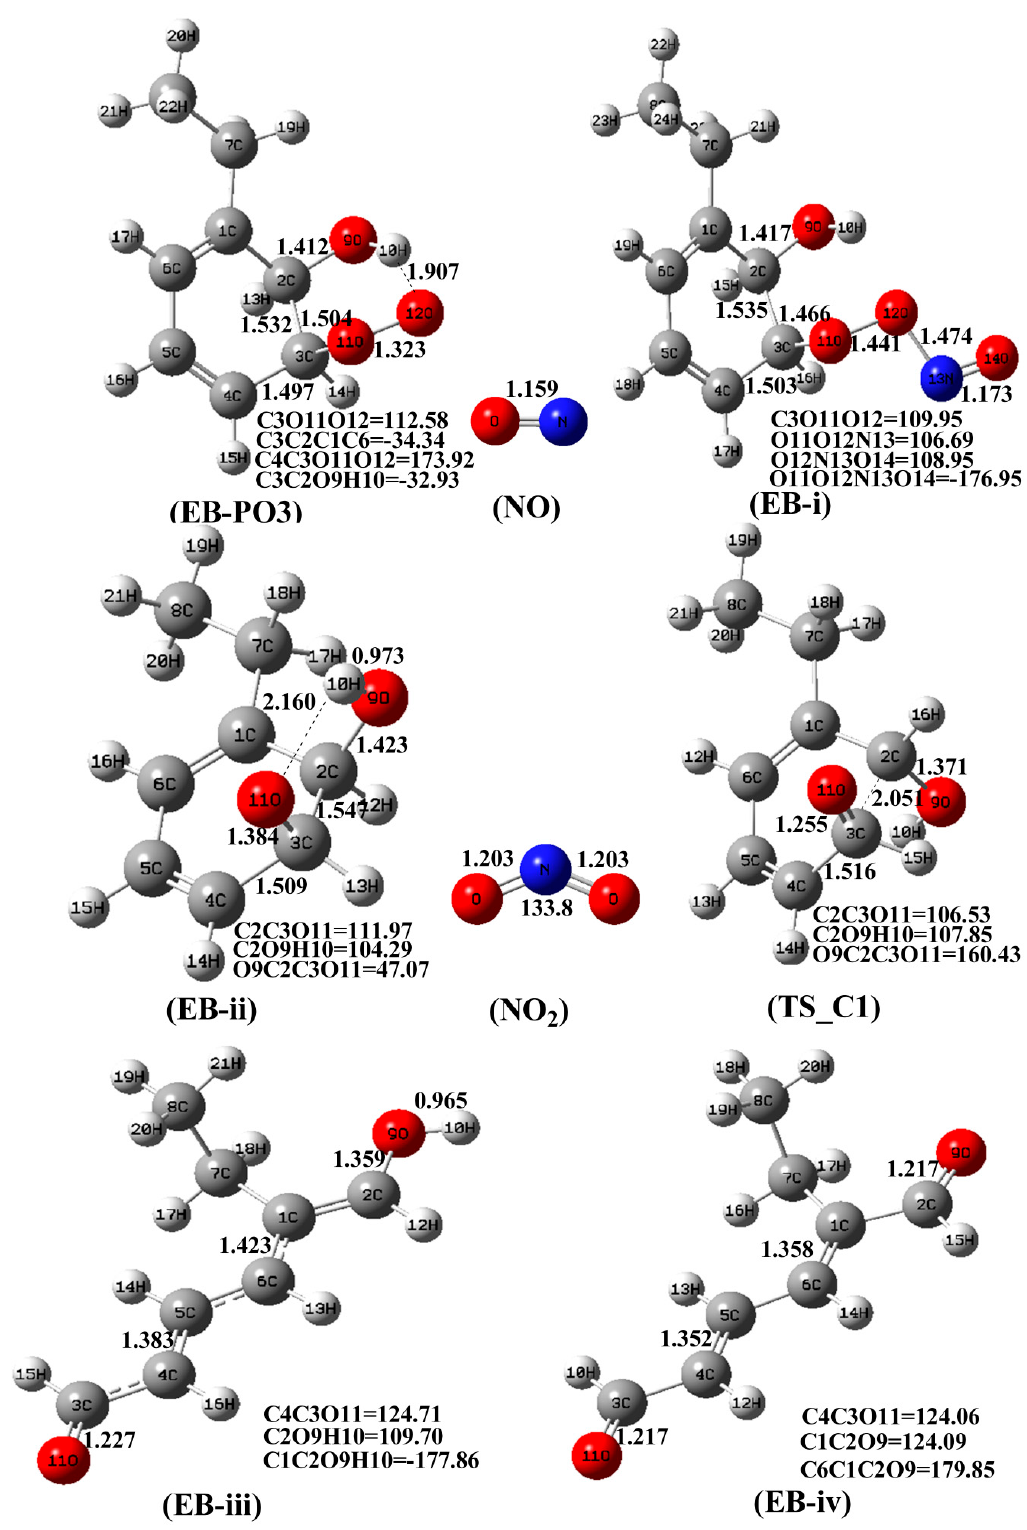
Figure 4. Optimized geometries of various species of Path C for the formation of 5-ethyl-6-oxo-2,4-hexadienal, as shown in Figure 1, at the BHandHLYP/6-311++G(d,p) level (Bond length: Å, Bond angle: °).